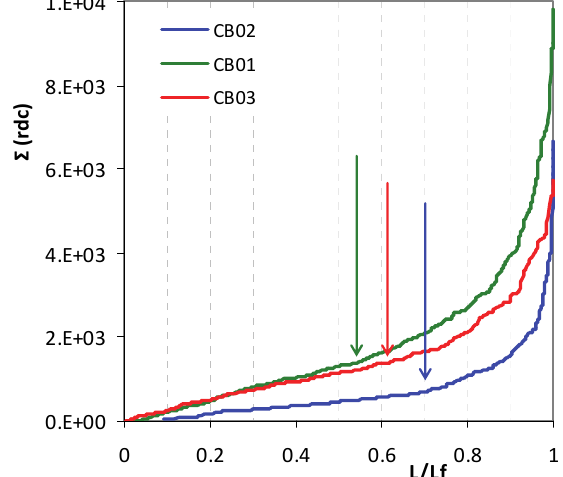
Figure 5: The cumulative ring down count of ΑΕ hits vs. normalized load (L/L f ) for the three conducted experiments.